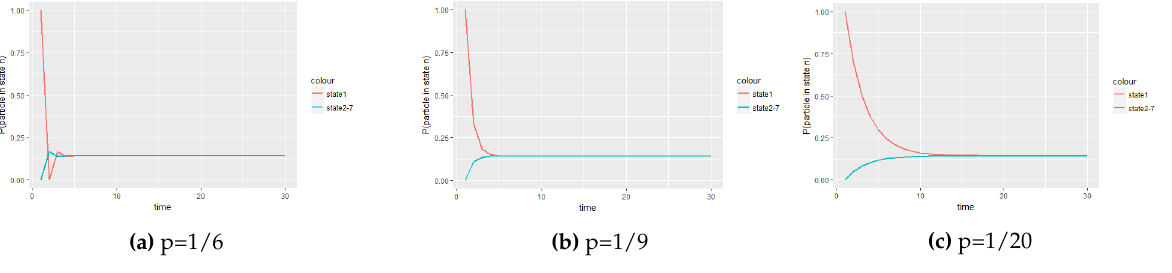
Figure 4. The panel of graphs to represent transitional probabilities against time interval of a transition matrix A with starting point at the central cell with with initial probability vector P 0 figures state 2, 3, 4, 5, 6 and 7 overlap because they have the same stochastic behavior to the process.